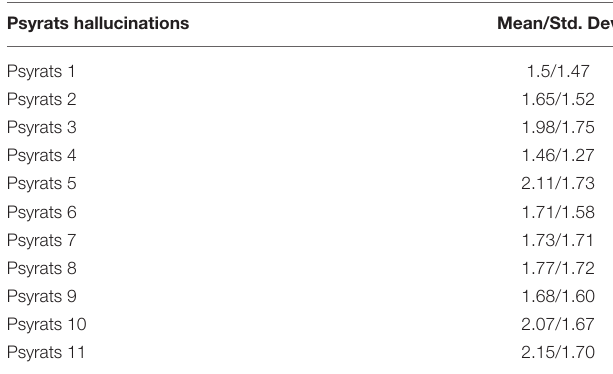
TABLE 2 | Characterization of the current dimensions of hallucinations according to PSYRATS. Psyrats hallucinations